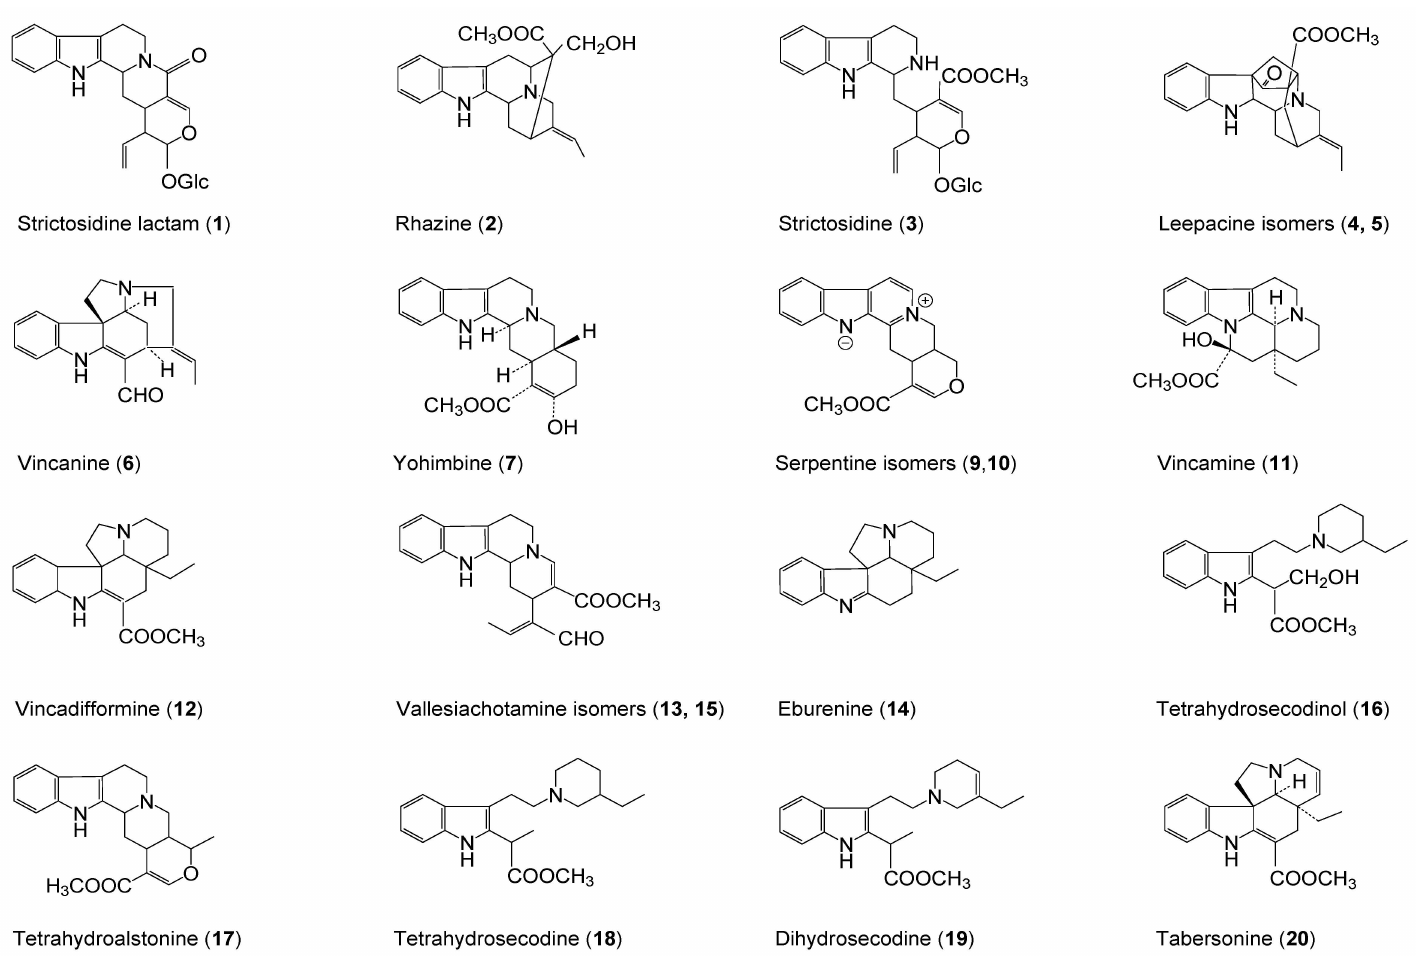
Figure 3. Structures of alkaloids identified by UPLC-PDA-MS. Numbers refer to compounds in Table 2. Compounds 6 , 7, 11 and 20 were identified by direct comparison with authentic reference samples, thus their structures are depicted with assignment of relative configurations. All other compounds, including an isomer ( 8 ) of yohimbine ( 7 ), were tentatively assigned based on their mass spectra and are therefore depicted without stereochemical assignment.